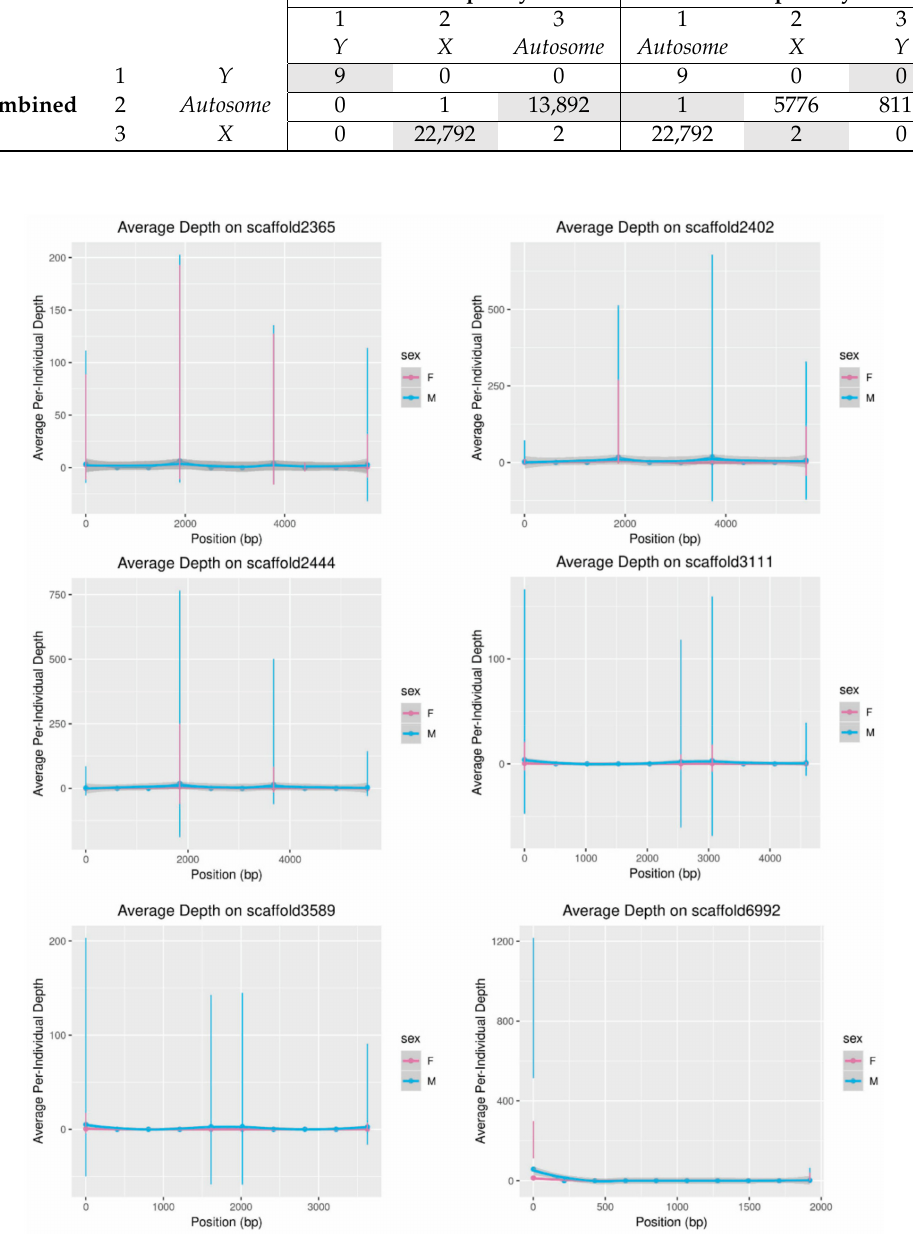
Table A1. Variation in window assignment under di ff erent clustering parameters. The combined analysis was conducted using both metrics. Although cluster number is arbitrary, the most likely chromosome type is indicated for each cluster based on the predicted distribution of scores among the X-chromosome, autosomes, and Y-chromosome. Defining clusters using each metric alone revealed that 36,696 windows were assigned to a Y-chromosome cluster based on at least one metric. Grey shading indicates cells where the most likely chromosome type matched between a single metric and the combined clustering analysis. CNV-Seq Only